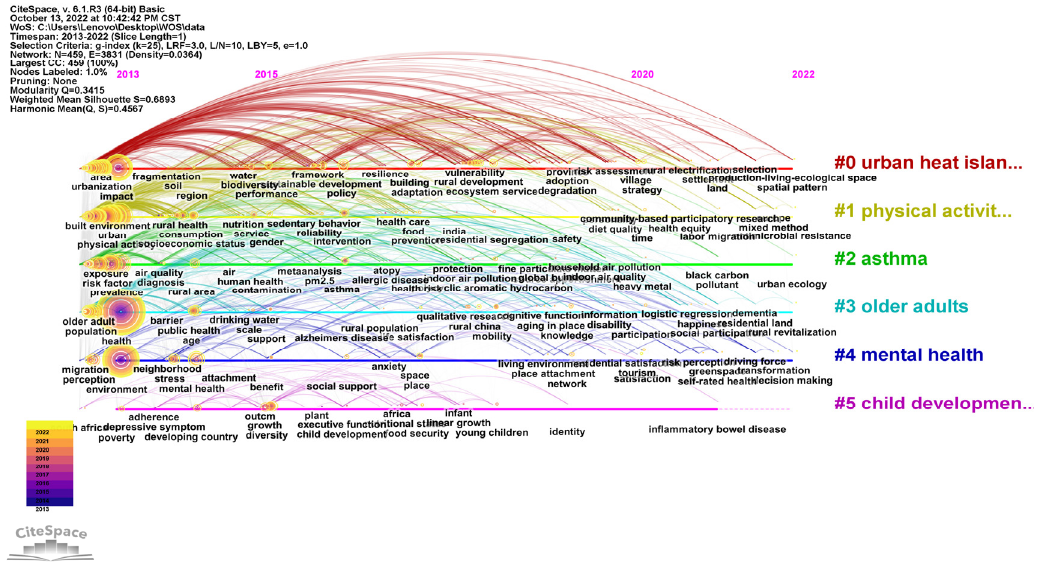
Figure 17. Timeline of keywords in rural human settlements research.